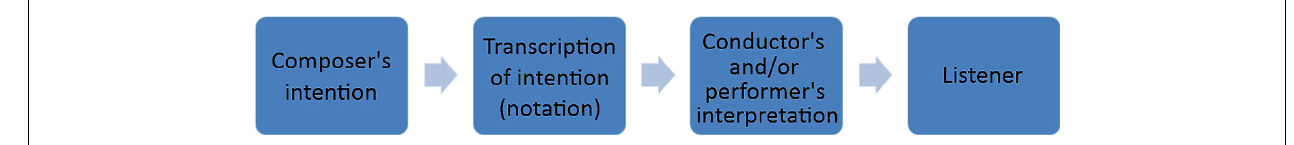
FIGURE 2 | Linear information-transmission model of musical communication. In this model, a performer evokes the work and delivers it to the listener. The work is conceived of as a fixed entity.The intentions are contained in the work, to be channeled by the performer.The performance exists to serve the work.